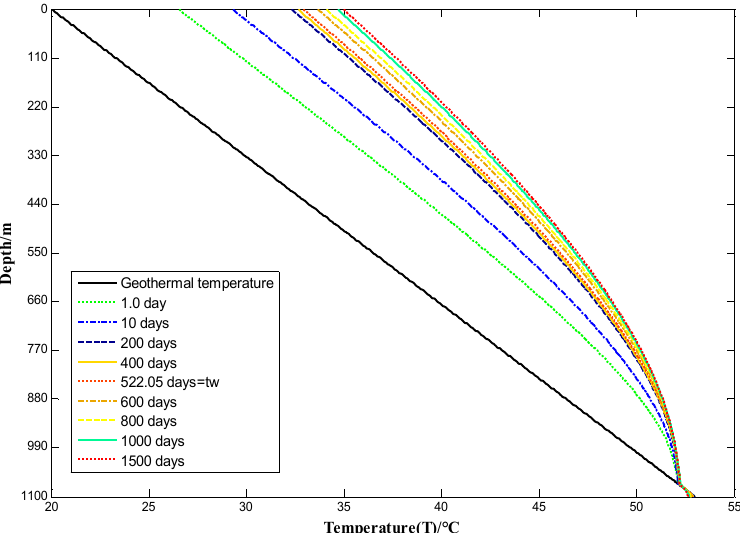
Figure 15. Fluid temperature in vertical tubing at the tubing-tubing wall interface ( r = 0.04 m, 0 m ≤ z ≤ 1100 m) with di ff erent production time ( t